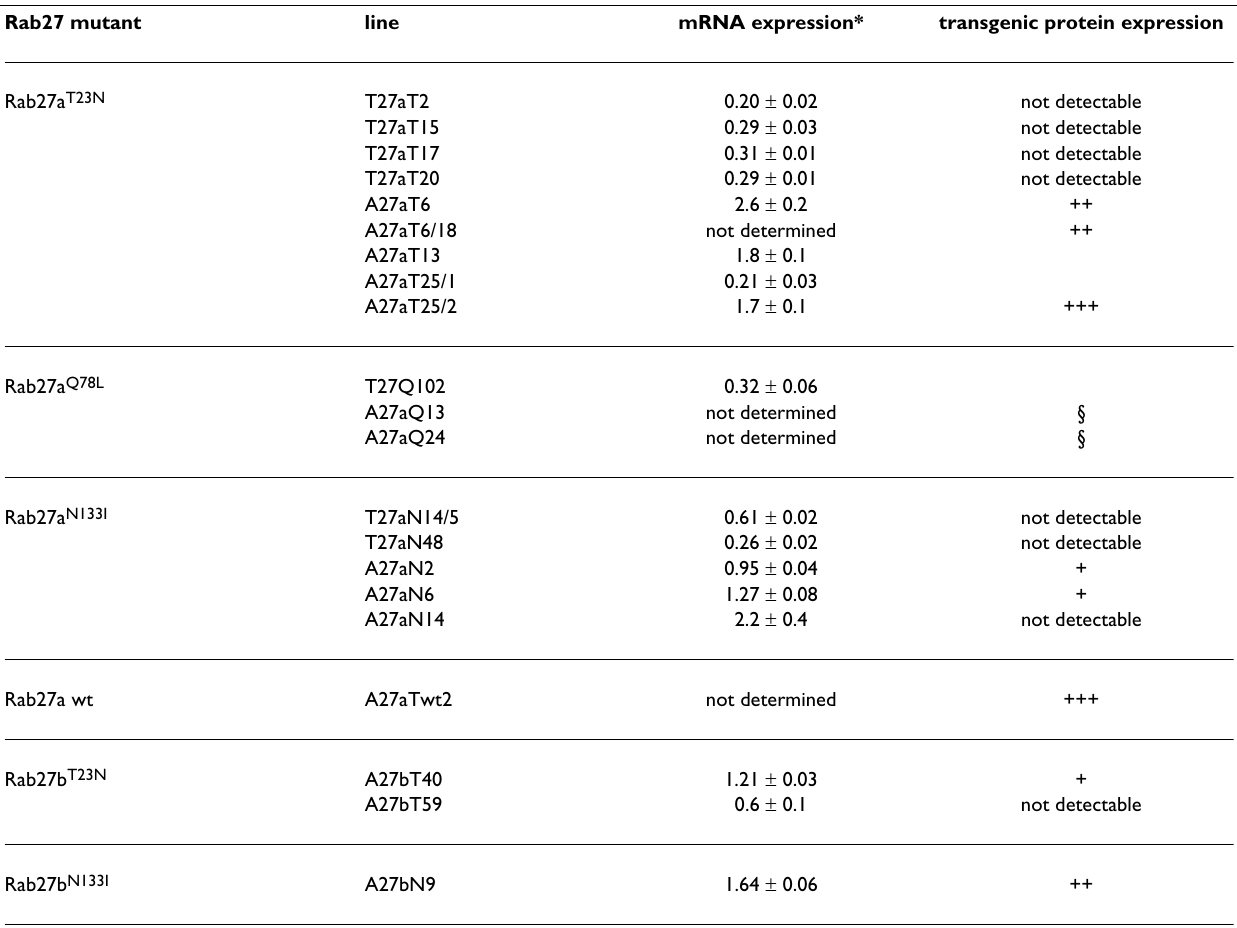
+++ represents transgenic Rab27 protein level similar to endogenous, ++ or + represent transgenic Rab27 protein level below endogenous, §very high levels of transgenic protein compared to endogenous; * mRNA Rab27 values are expressed as (endogenous + transgenic Rab27a or Rab27b)